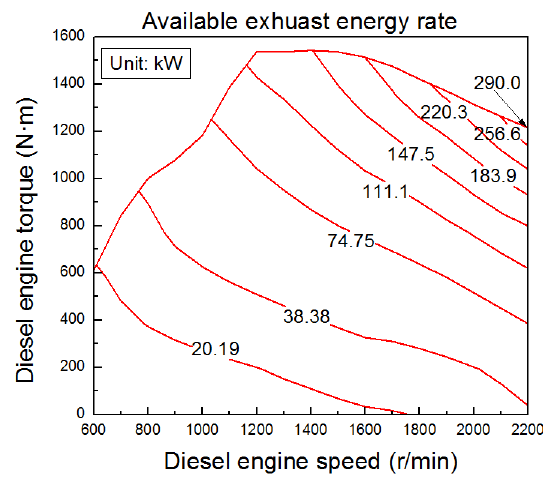
Figure 3. Available exhaust energy rate of the diesel